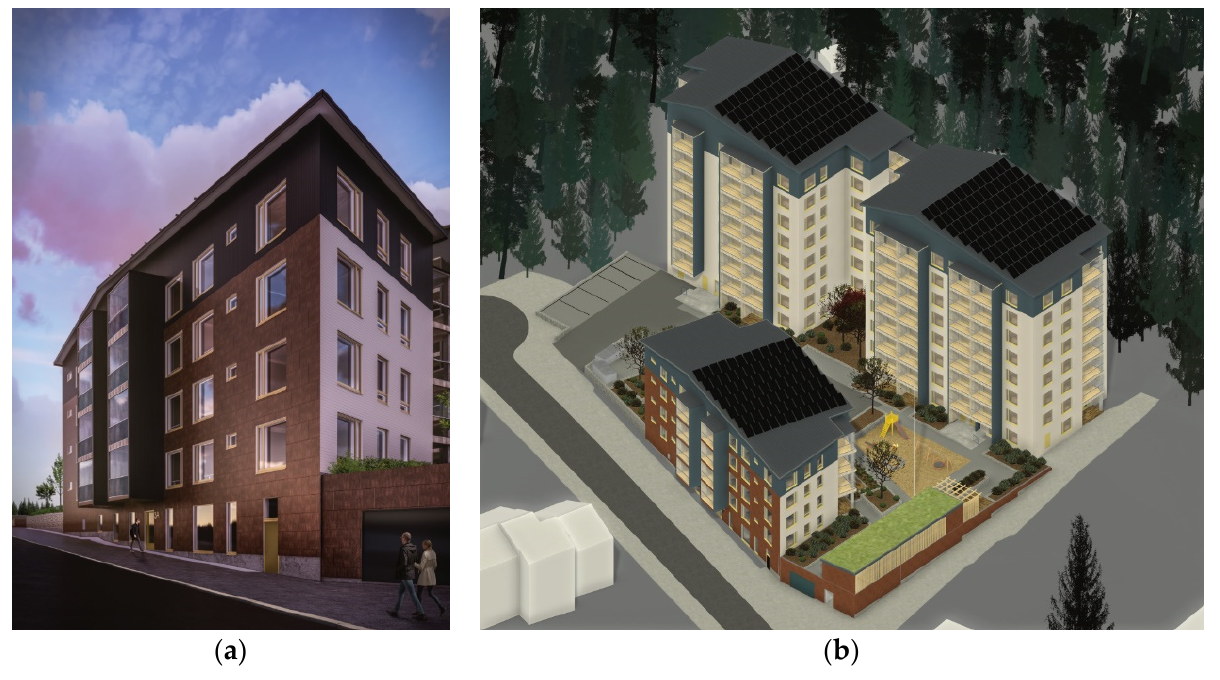
Figure 3. The designed five-story hybrid building in three dimensions (3D): ( a ) standalone view; ( b ) the site plan.